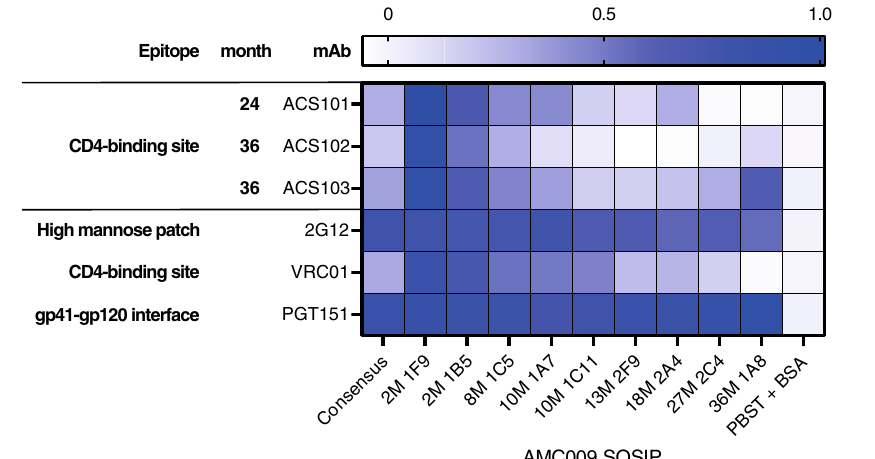
Fig. 6 | Binding of ACS101, ACS102, and ACS103 to longitudinal Envs isolated from donor H18877. Binding of ACS101, ACS102, and ACS103 to longitudinal Envs isolated from donor H18877 using biolayer interferometry. Heat map representing